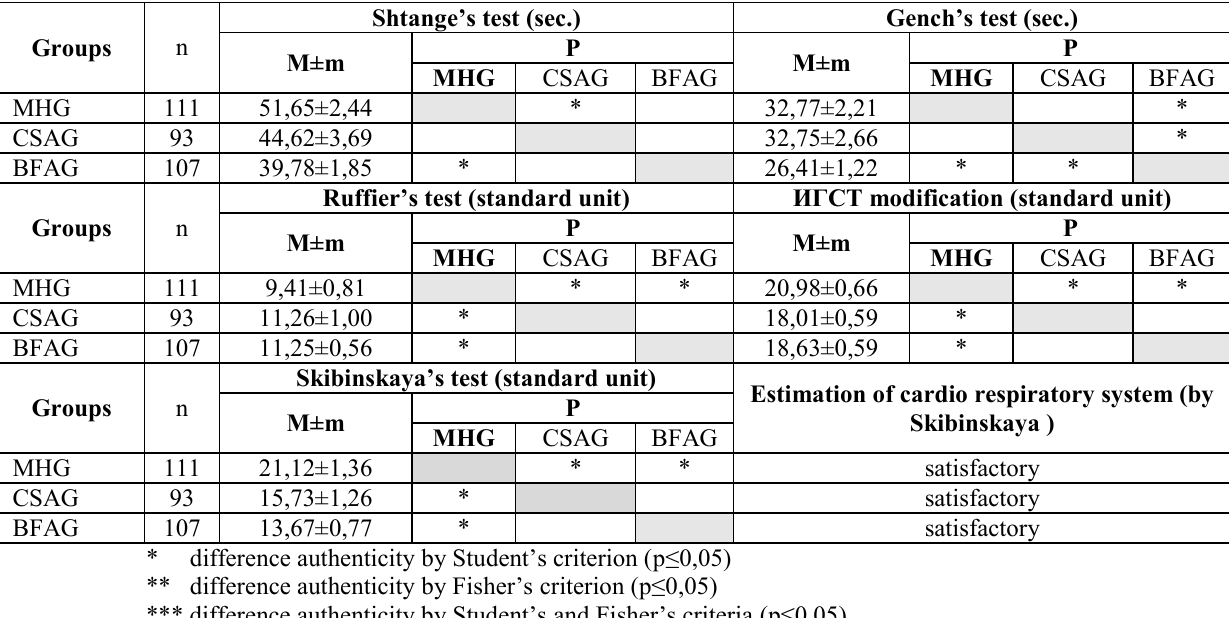
Functional state of backbone and muscular corset of EG (experimental group) (n=54) and CG (control group) (n=53) students before and after pedagogical